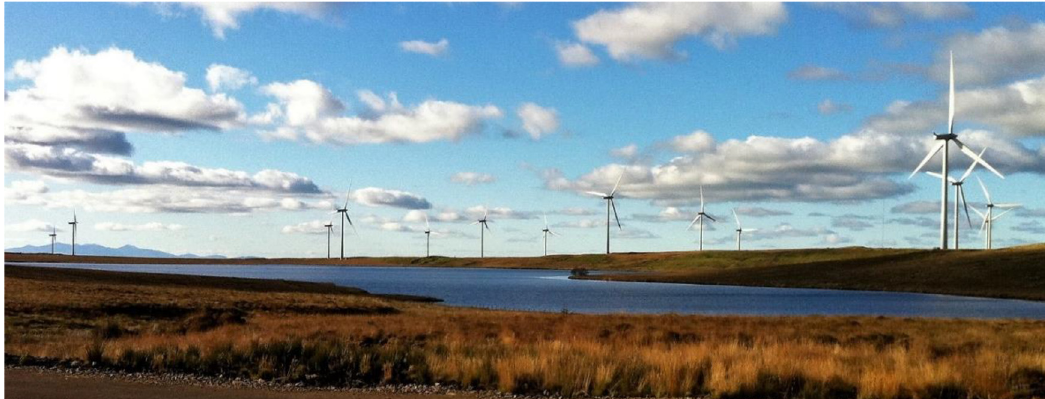
Fig. 22. UK, On-shore wind farm,